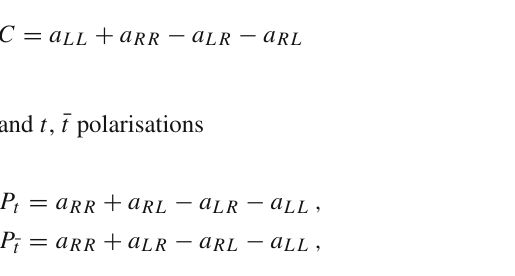
Table3,togetherwiththepredictionsdirectlycalculatedfrom the SM and CMDM Monte Carlo samples, at parton